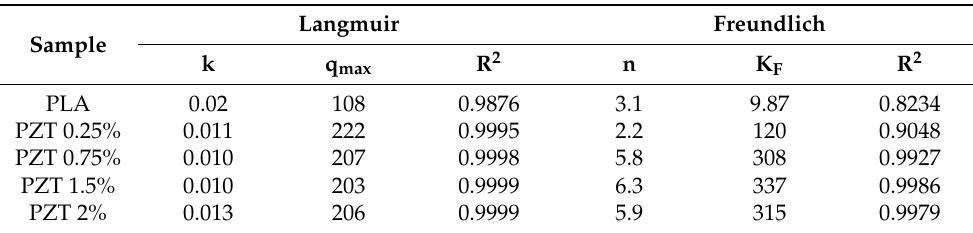
Table 4. Parameters of the isotherm constants and correlation coefficients were calculated for MB adsorption in PZT nanocomposites.